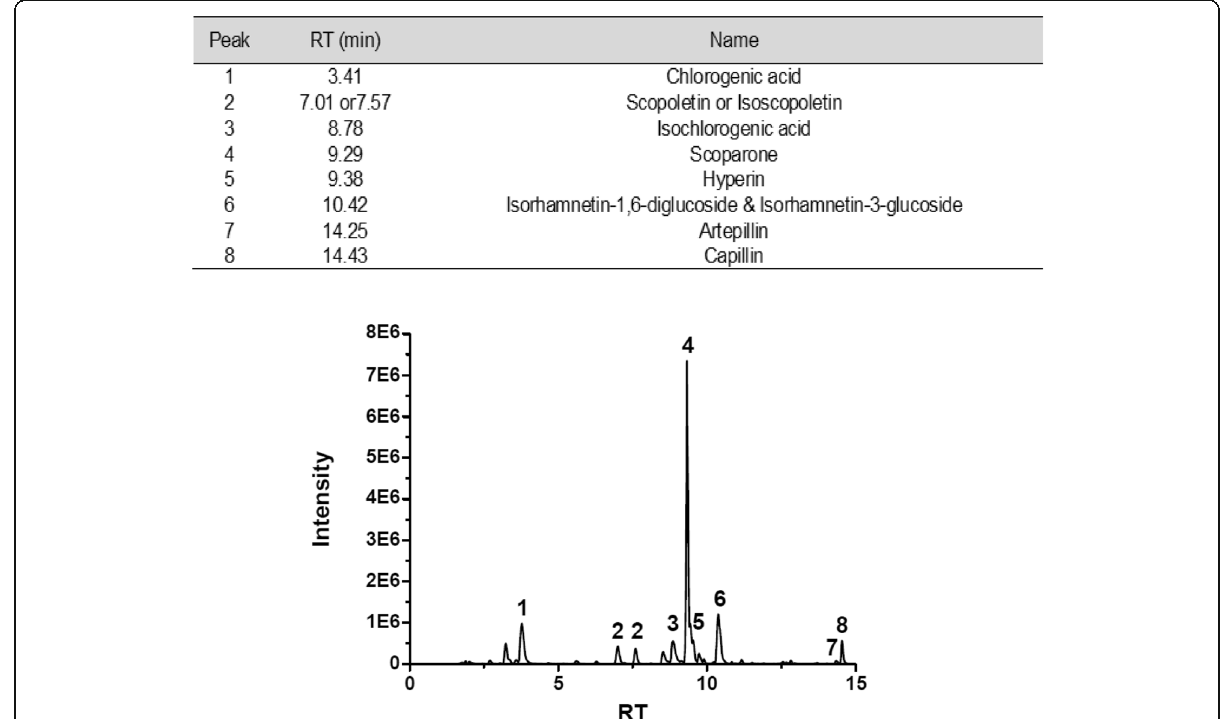
Fig. 1 HPLC-MS chromatogram fingerprinting of